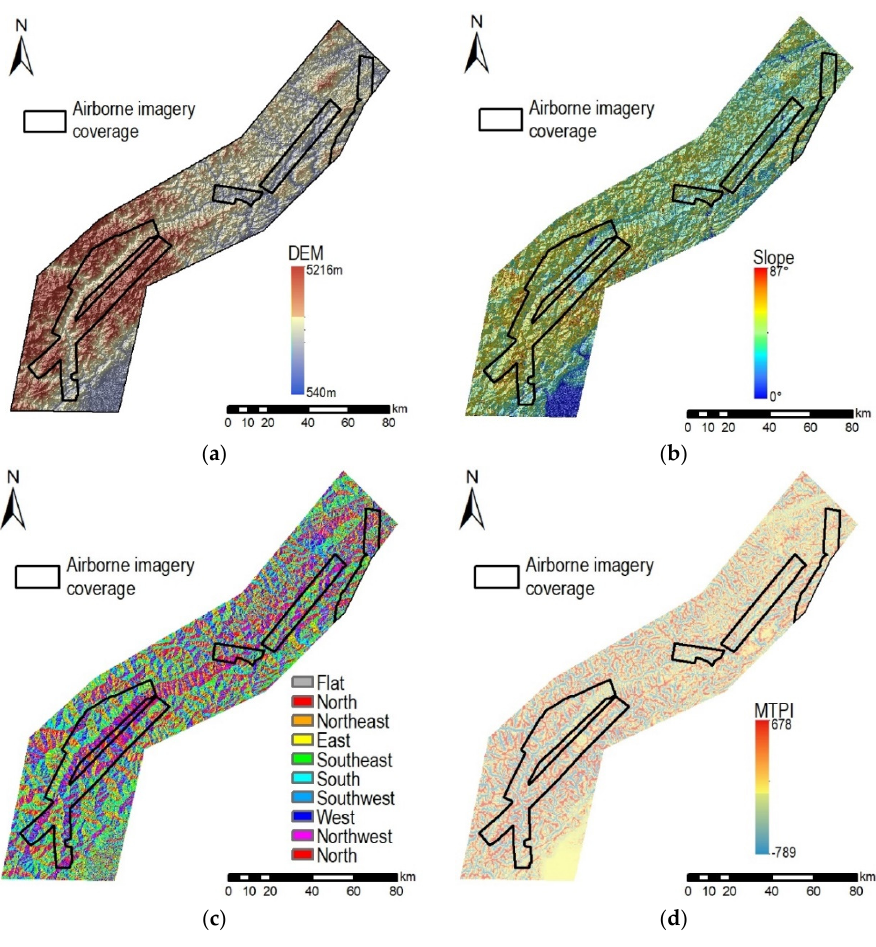
Figure 4. Topography factors of post-earthquake landslides. ( a ) Digital elevation model (DEM); ( b ) Terrain slope; ( c ) Terrain aspect; and ( d ) Multi-scale topographic position index (mTPI). Remote Sens. 2020 , 12 , x FOR PEER REVIEW